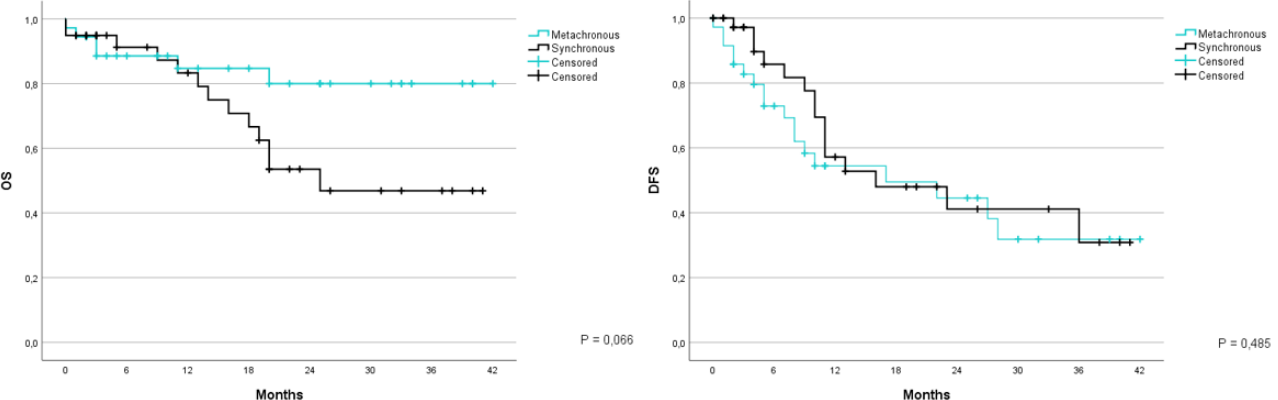
Figure 2. Kaplan-Meier curve for OS and DFS in patients who underwent liver resection for CRLM stratified based on the primary tumor site. (Left colon, right colon, rectum). OS: Overall Survival; DFS: Disease Free Survival; CRLM: Colorectal liver metastases. The correlation between survival and tumor T stage for the primary tumor was also analyzed. OS at 1 and 3 years was 100% for patients with T1; 100% and 92.9% respectively for T2; 86.1% at 1 year for T3; 75% and 56.3% at 1 and 3 years for T4 ( p = 0.054). DFS was 100% respectively at years 1 and 3; 56.2% and 32.1%; 56.9% at year 1; and 48.2% and 32.1 at years 1 and 3 respectively ( p = 0.696) (Figure 3).